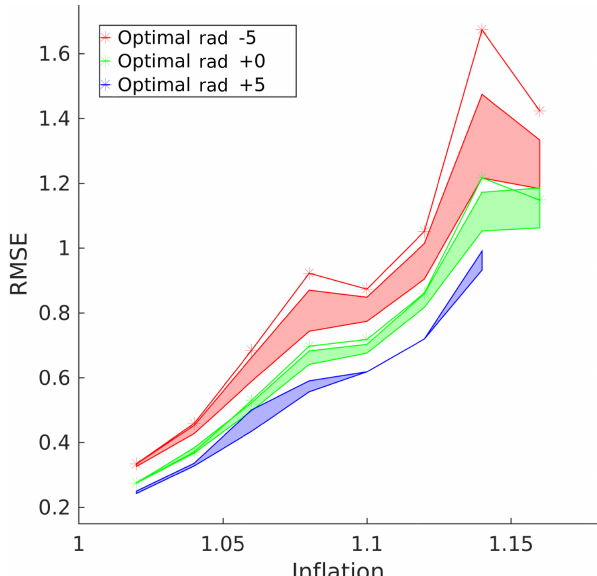
Figure 9. Quasi-geostrophic model adaptive localization raw RMSE. The green line represents the same optimal constant local- ization radius as in Fig. 8. The red line represents the error for the radius − 5 units below, and the blue line, if it had not experienced filter divergence, would have represented + 5. The correspondingly colored areas represent the ranges of error of the adaptive local- ization scheme obtained by fixing the mean, ¯ υ , to be that of the constant scheme and ranging over the variance.